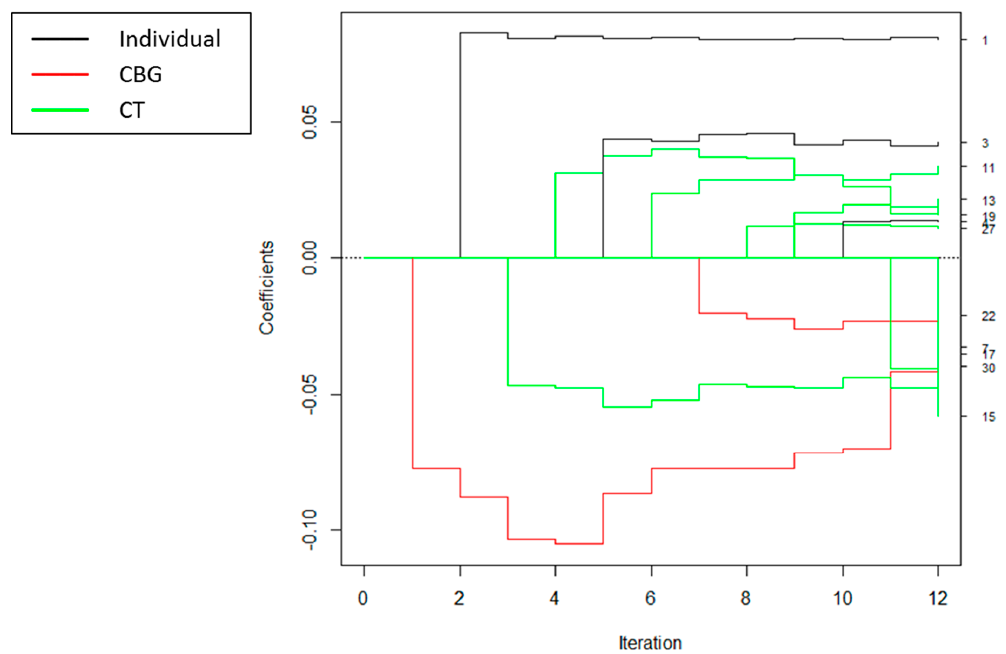
Figure 2. Coefficient paths for spatial scale forward stepwise regression to explain BMI z-scores. The scale at which each covariate entered the model is indicated by the legend. The numbers on the right-hand side of the figure are the variable numbers listed in Table 1.